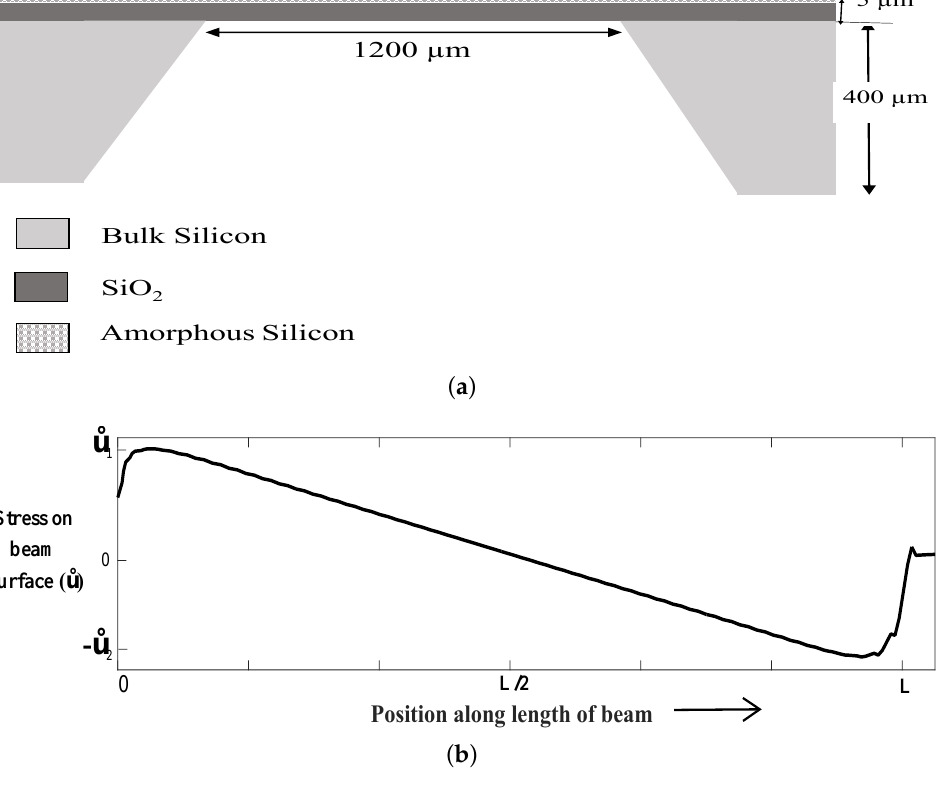
Figure 3. ( a ) Side view of portion of the sensor showing beam dimensions; ( b ) variation of stress along the length of the